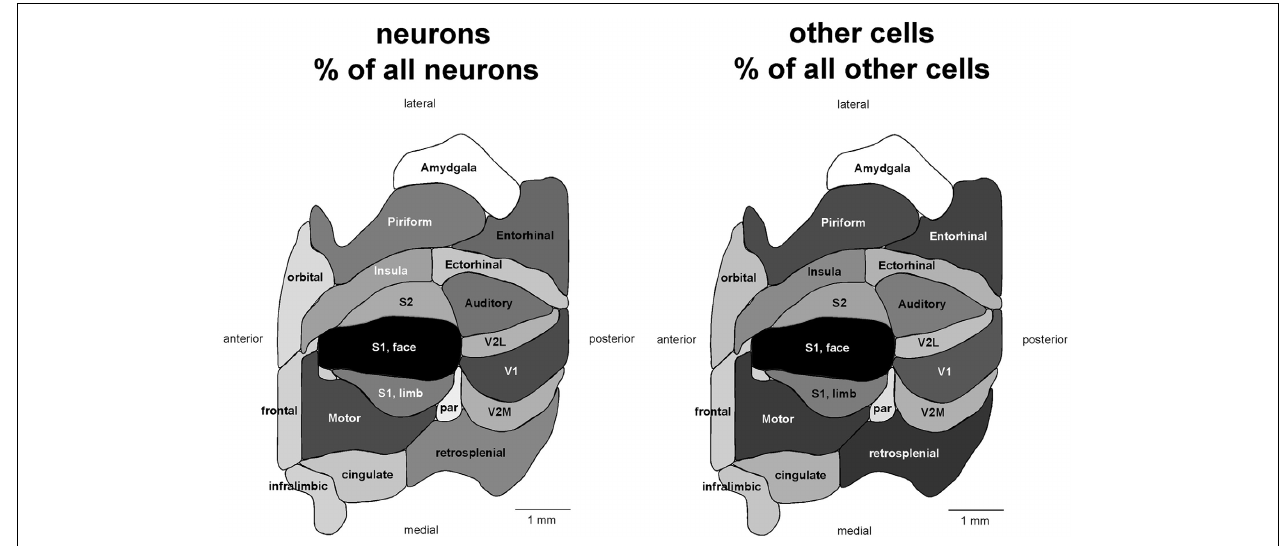
FIGURE 1 | Distribution of absolute and relative numbers of neurons (left) and other cells (right) across the 18 functional areas of the mouse cerebral cortex. Functional areas are drawn according to their surface reconstruction from Franklin and Paxinos